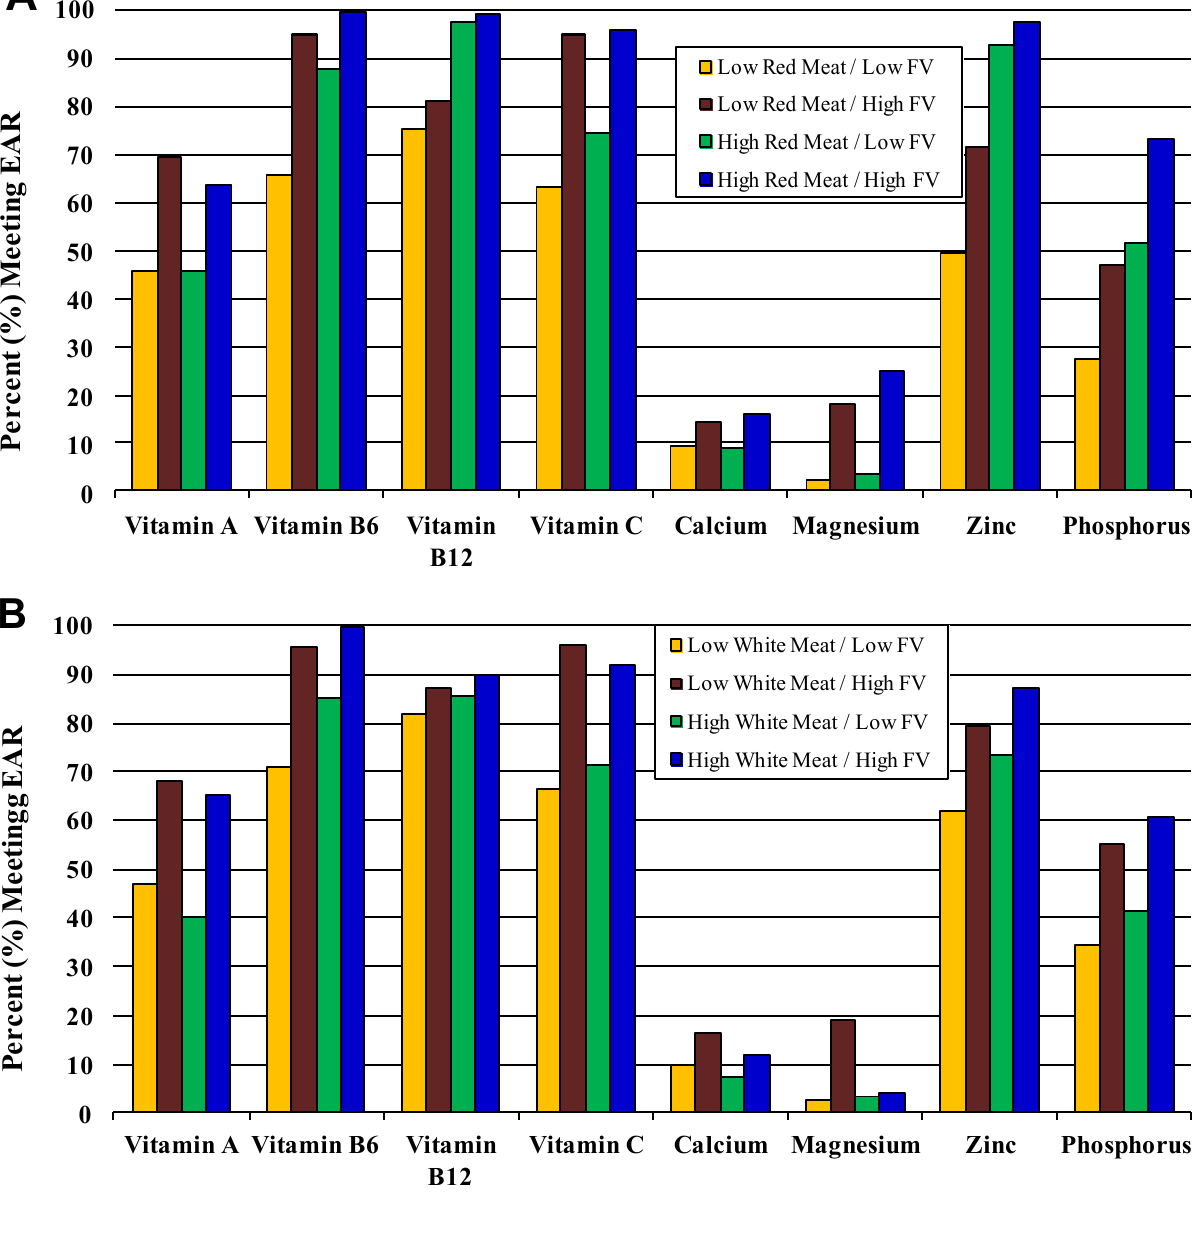
Figure 2. Percent of 14–18 year-old girls meeting EAR according to combined effects of fruits and vegetables and ( A ) red meat and ( B ) white meat (poultry and fish). Low ( vs. high) fruit and vegetable intake ≤50% ( vs. ≥50%) of recommended 8 servings of total fruit and vegetables/day. Low ( vs. high) dairy: <75% ( vs. ≥75%) of recommended 3 dairy servings/day. Low ( vs. high) red meat: <75% ( vs. ≥75%) of recommended 5 one-ounce servings of total meat/day. Low ( vs. high) white meat (poultry and fish): <40% ( vs. ≥40%) of 5 one-ounce servings of total